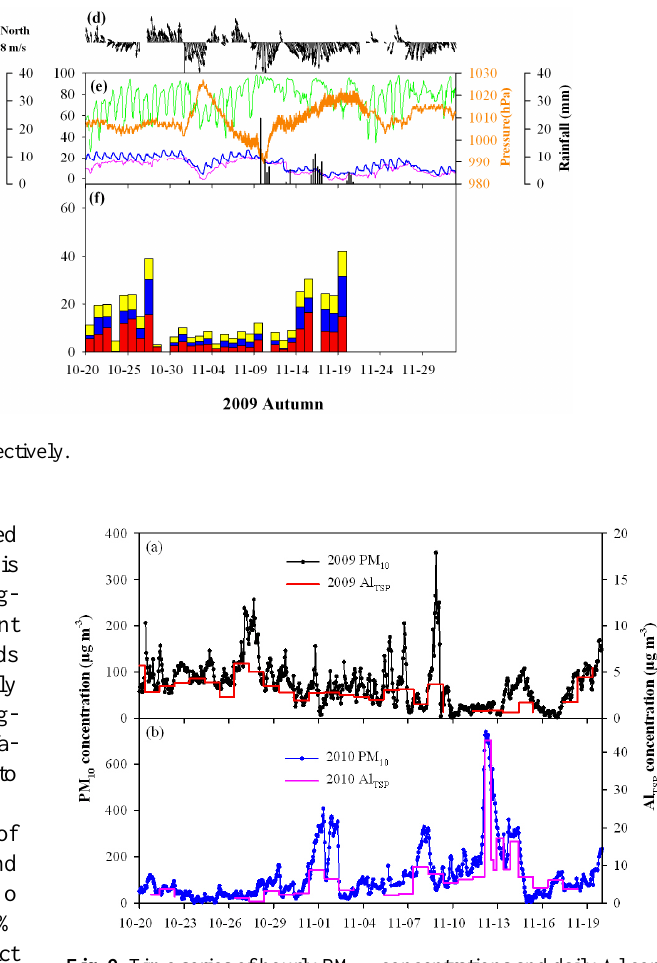
Fig. 9. Time series of hourly PM 10 concentrations and daily Al con- Figure 9. Time-series of hourly PM 10 concentrations and daily Al concentrations in TSP (Al TSP ) during the autumn study period from October 20 to November 19 in 2009 (a) and 2010 (b), respectively. centrations in TSP (Al TSP ) during the autumn study period from 20 October to 19 November in 2009 (a) and 2010 (b) ,